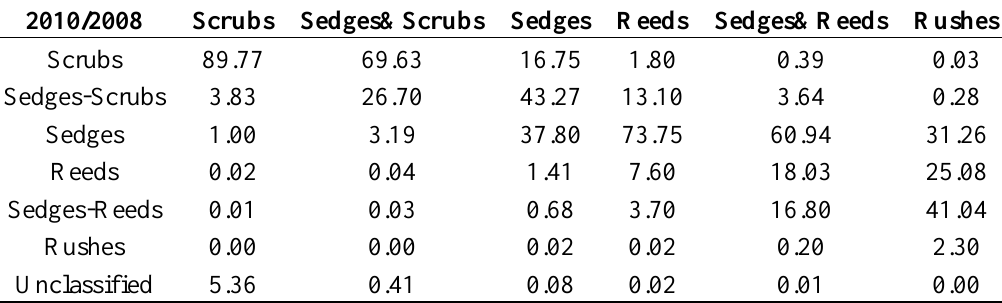
Table 5. Class cover area changes in